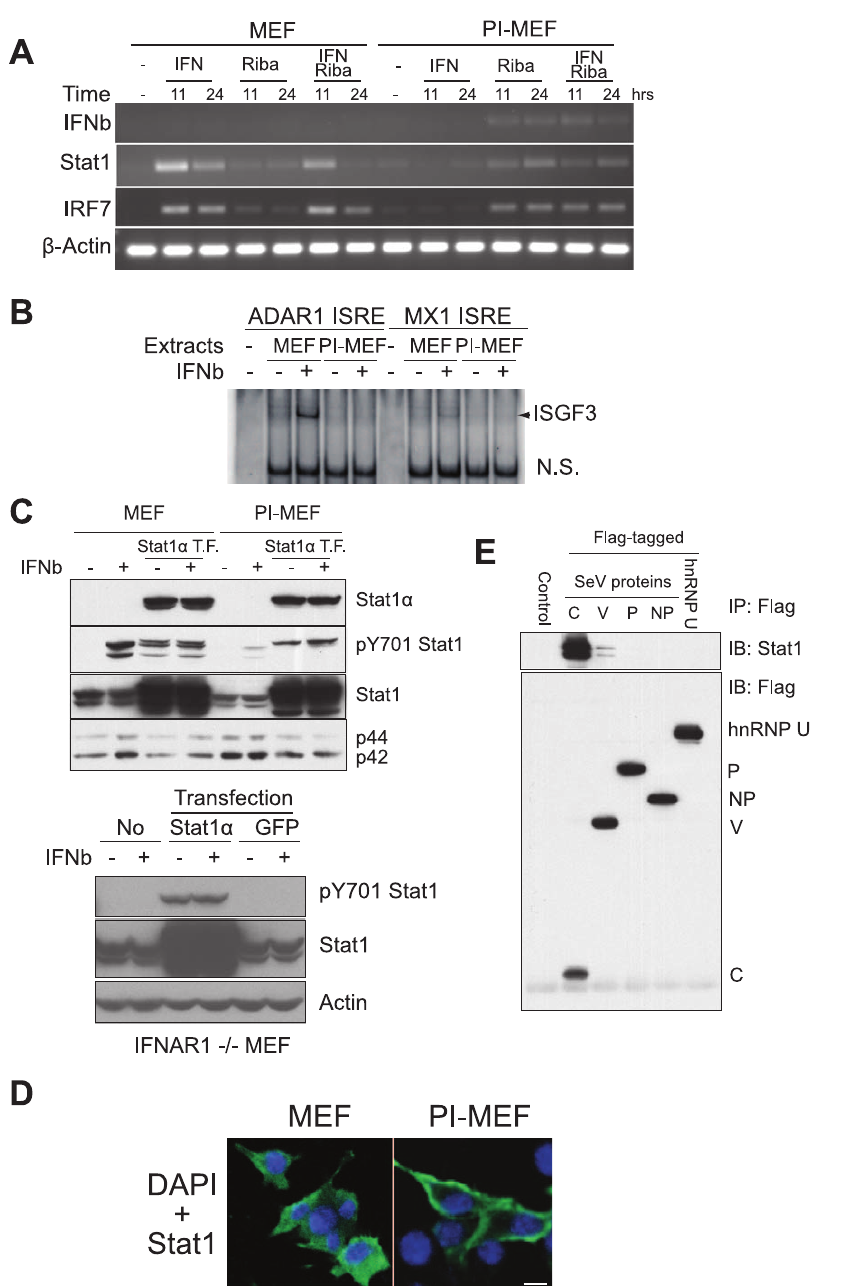
Figure 5. Interferon signaling is defective in PI-MEFs. A . ISGs are not activated by recombinant IFN b in PI-MEFs, but ribavirin treatment activated the expression of ISGs and IFN b . Control MEFs and PI-MEFs were treated with recombinant IFN b (1000 U/ml) or ribavirin (100 m g/ml) either alone or in combination for 11 and 24 hrs. Cells were harvested for total RNA extraction, and the expression of IFN b , Stat1, IRF7 and b -Actin mRNAs were analyzed by RT-PCR. B . ISGF3 complex formation is blocked in PI-MEFs. Control MEFs and PI-MEFs were stimulated with recombinant IFN b protein for 1 hr, and total cell extracts prepared and assayed for the ISGF3 formation on ISRE DNA probes derived from the ADAR1 and MX1 genes. C . Reduced phosphorylation of STAT1 tyrosine 701 in PI-MEFs after IFN treatment. Top: Control MEFs and PI-MEFs were transfected with a plasmid encoding Stat1 a protein for 24 hrs, transfected and non-transfected cells were stimulated with recombinant IFN b for 1 hr. Total protein was prepared for western blot analysis with antibodies against Stat1, phospho-tyrosine 701 Stat1, Stat1 a and MAP kinase p42/p44. Bottom: the same experiments were conducted in IFNAR1 deficient MEFs and the expression of Stat1 and phospho-Y701 Stat1 were analyzed by western blotting. GFP was also transfected as a control. D . Plasma membrane localization of Stat1 protein in PI-MEFs. Control MEFs and PI-MEFs were transfected with a plasmid encoding Flag-tagged Stat1 protein. 24 hrs later cells were fixed and subjected to immunofluorescent staining with an anti-Flag antibody (green). Blue: DAPI staining for nuclei. Scale bar, 10 m m. E . SeV C protein specifically interacts with Stat1 protein. Constructs for Flag-tagged SeV C, V, P and NP proteins were transfected into MEFs, 24 hrs later, whole cell extracts were prepared and subjected to anti-Flag M2 bead immunoprecipitation (IP). The associated proteins were eluted and separated on SDS-PAGE, blotted and probed with an anti-Stat1 antibody. An hnrnp U expression construct was also included as a control. IB: immunoblot.